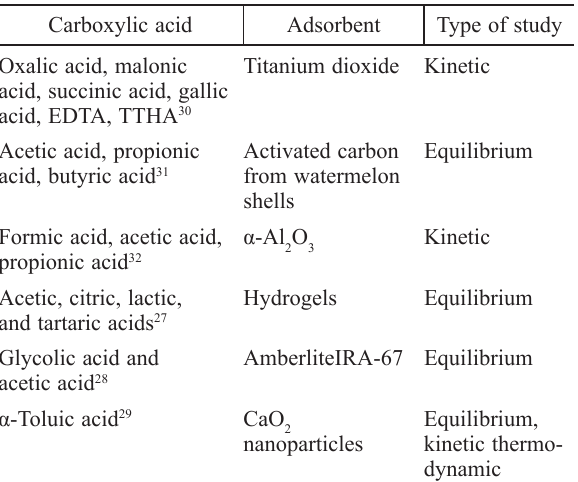
Table 1 – Summary of a few studies conducted on carboxylic acid